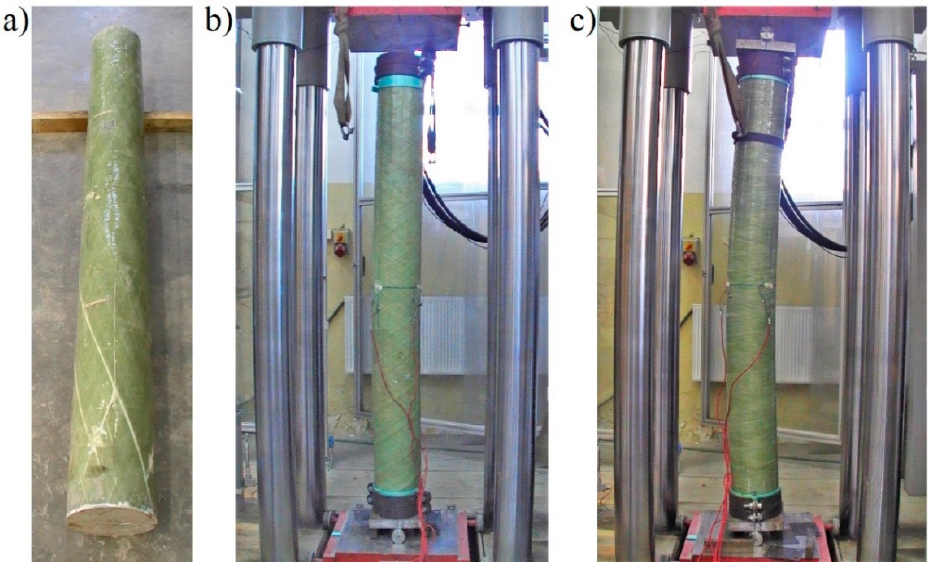
Figure 14. View after failure of 200-cm-long CFFT test specimens with fiber winding: ( a ) 20°, ( b ) 55° and ( c ) 85°.